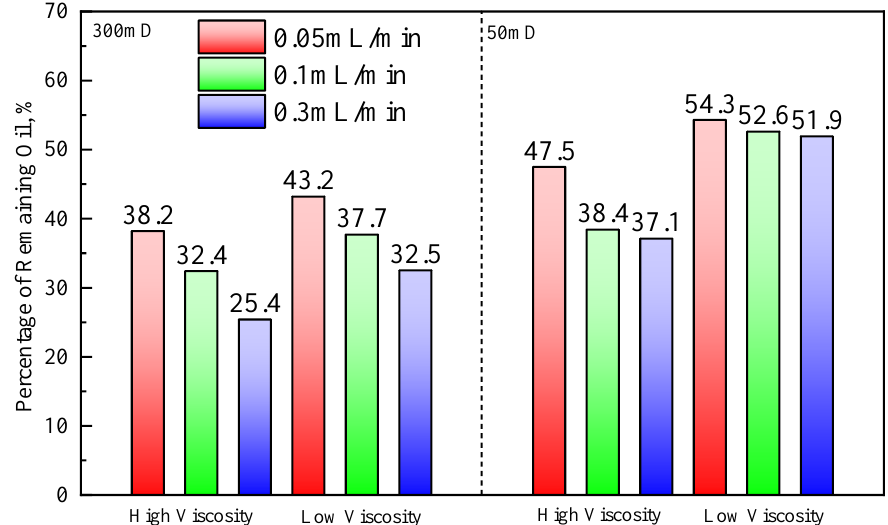
Figure 12. Variation of residual oil content in the displacement of two binary systems under different flow intensity.